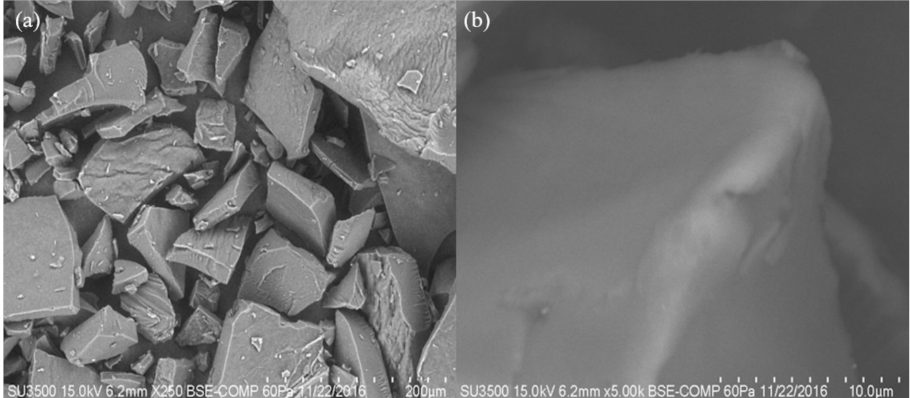
Figure 10. Micrographs of modified starch formulation 1 after undergoing microwave thermal process. ( a ) 250 × , ( b ) 5000 ×